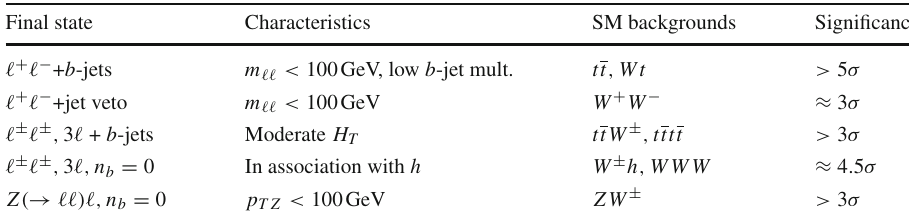
Table 4 Summary of the status Final state Characteristics SM backgrounds of the multi-lepton anomalies at the LHC, where (cid:2) = e ,μ